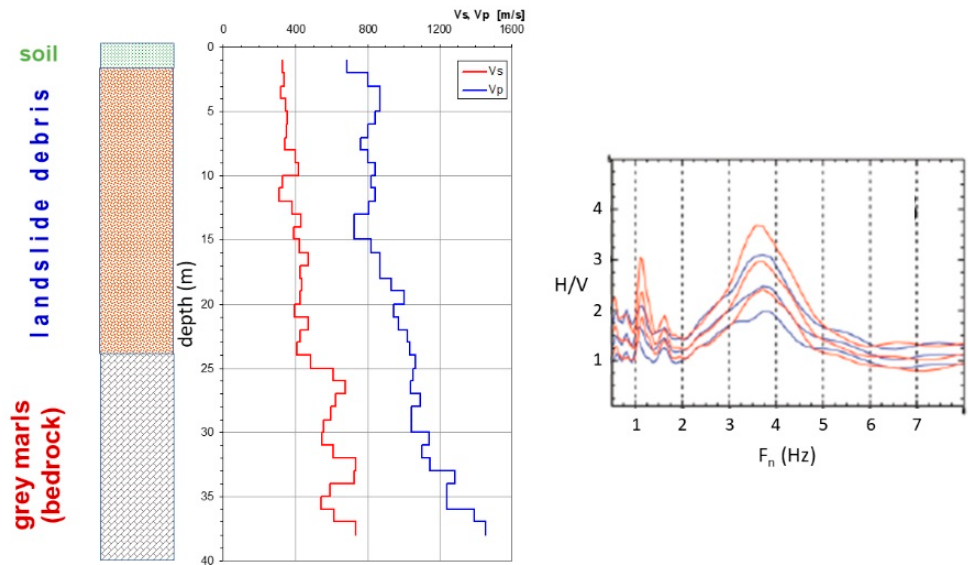
Figure 1. Comparison between stratigraphic log, Vs profiles from down-hole and ambient noise in an Apennines site characterised by debris cover (landslide) on marly geological substratum (modified from [10]). Similar cases are frequent in the